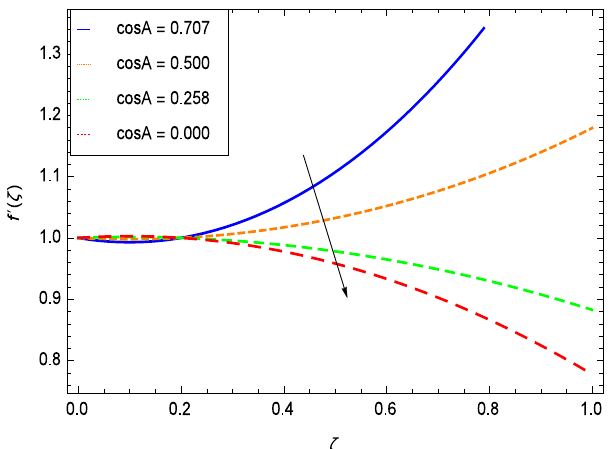
Figure 10. Flow layer at h = − 3.00, β = 0.10, φ = 0.40, M = 2.00, n = 1.50, S = 0.50, We = 0.50 with the enhancement in cos A .